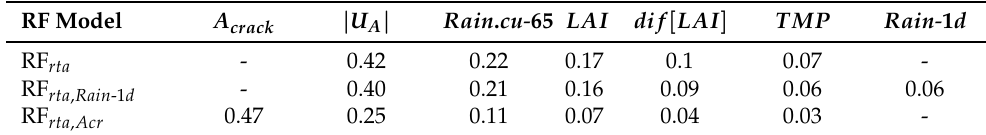
Table 4. Feature importance for real-time assessment RF